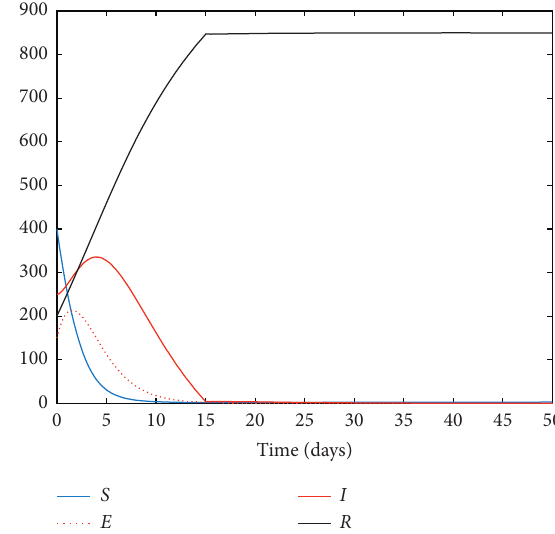
Figure 5: Evolution of the populations with the nonnegative control actions and n � 15 days.